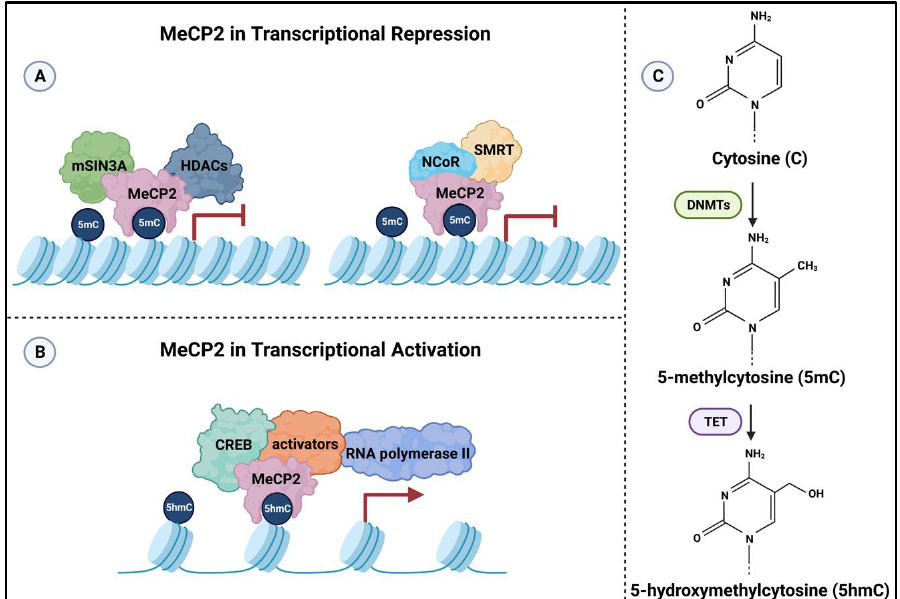
Figure 2. The role of MeCP2 in transcriptional regulation. ( A ) Upon binding to methylated CpG di-nucleotides (5mC), MeCP2 recruits repressor complexes such as mSIN3A, HDACs, and NCoR-SMRT to suppress gene transcription. ( B ) Upon binding to 5hmC, MeCP2 interacts with CREB to promote transcriptional activation and recruitment of other activators. ( C ) DNMTs add methyl groups onto the fifth carbon of cytosine residues in the CpG di-nucleotides to form 5mC, whereas TET enzymes oxidize the methyl groups to form 5hmC. 5hmC: 5-hydroxymethylcytosine; 5mC: 5-methylcytosine; CREB: cAMP response element binding protein; DNMTs: DNA methyltransferases; HDACs: histone deacetylases; mSIN3A: mammalian switch-independent 3A; MeCP2: methyl-CpG binding protein 2; NCoR: nuclear receptor corepressor; SMRT: silencing mediator for retinoid and thyroid hormone receptors; TET: ten–eleven translocation. Information obtained from [13,15,53,54,64,87,92–94]. Figure is created with